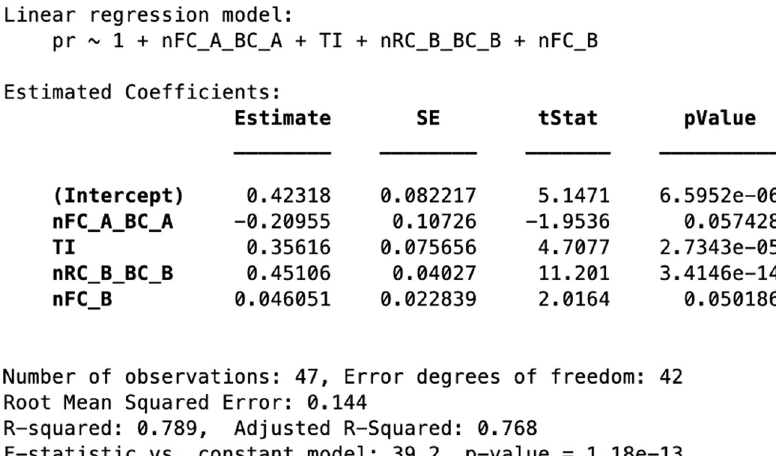
Figure 4: Final tenfold cross - validated and stepwise - improved linear regression for the trustor. nFC_A_BC_A is / FC BC A A , nRC_B_BC_B is / RC BC A B , nFC_B is FC B , and pr is the probability that trust was